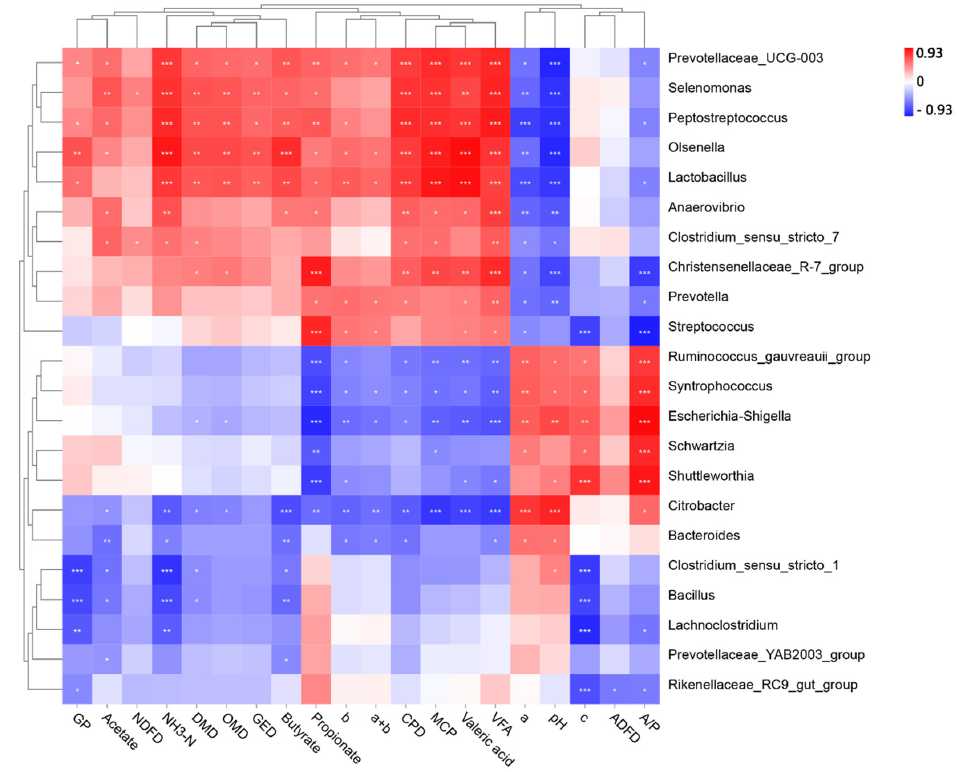
Figure 3. Correlations of the dominant bacterial biomarkers with rumen fermentation parameters. Note: The dominant bacterial biomarker taxa: relative abundance ≥ 0.5% with lowest cross-validation error screened by random forest machine learning algorithm in Table 7. GP, gas pro-